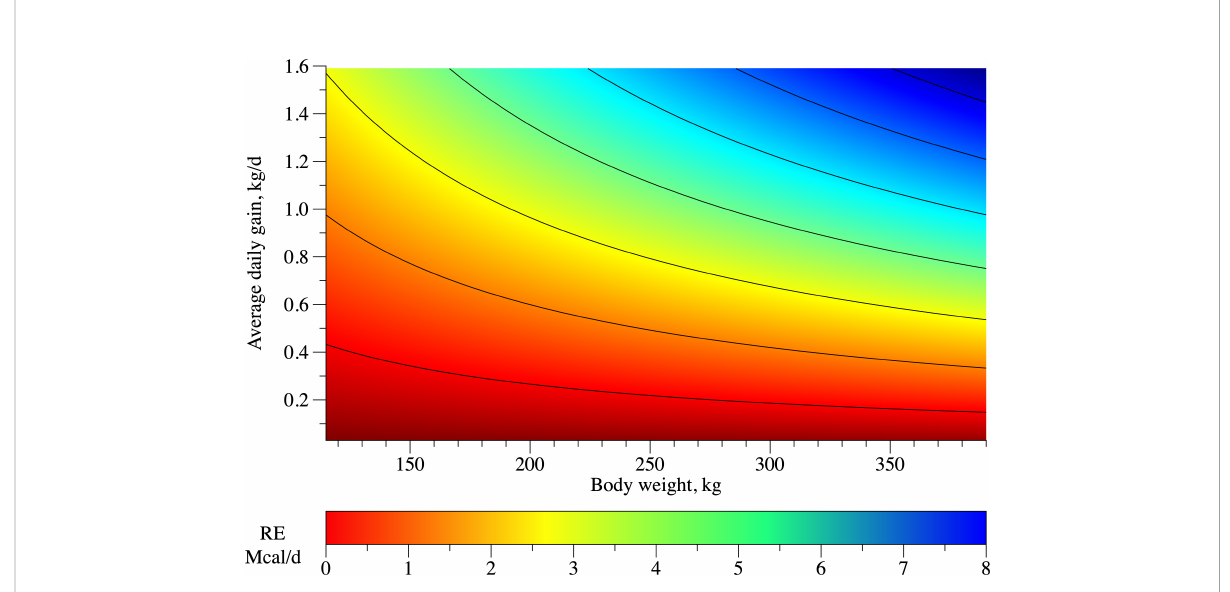
FIGURE 2 Representation of retained energy (RE; Mcal/day) equation of dairy heifers of three breed compositions (BC) fed at three feeding levels (FL);